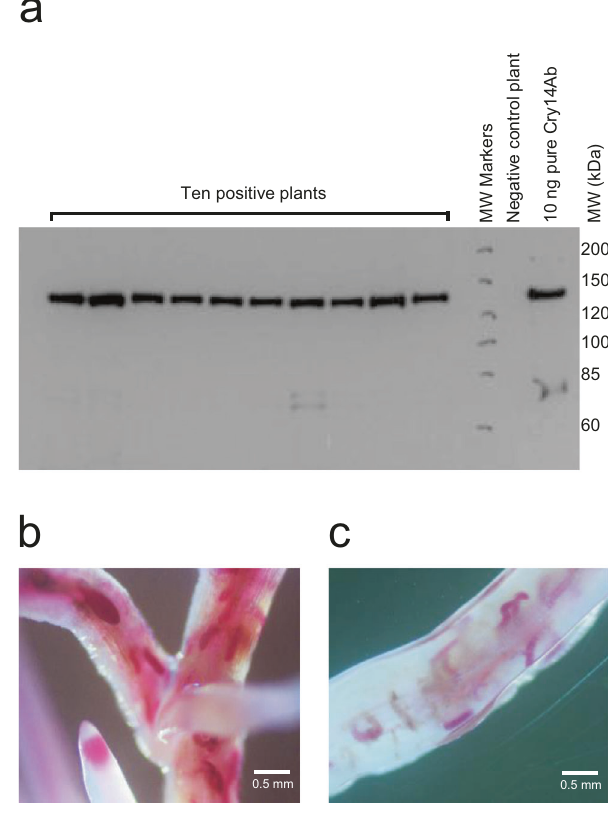
Fig. 8 The ability of Cry14Ab to reduce Heterodera glycines infection in roots of plants grown in the greenhouse was assessed. a Western blot of 10 individual T2 homozygous plants from event SB166, showing consistent accumulation of Cry14Ab protein. A second blot of another 9 plants showed similar results. b H. glycines -infested roots of soybean negative control event SB172, stained pink with acid fuchsin 10 days post infestation. Four plants were imaged, of which one is shown. c H. glycines -infested roots of soybean Cry14Ab event SB166, stained pink with acid fuchsin 10 days post infestation. Four plants were imaged, of which one is shown. Source data are provided as a Source Data fi